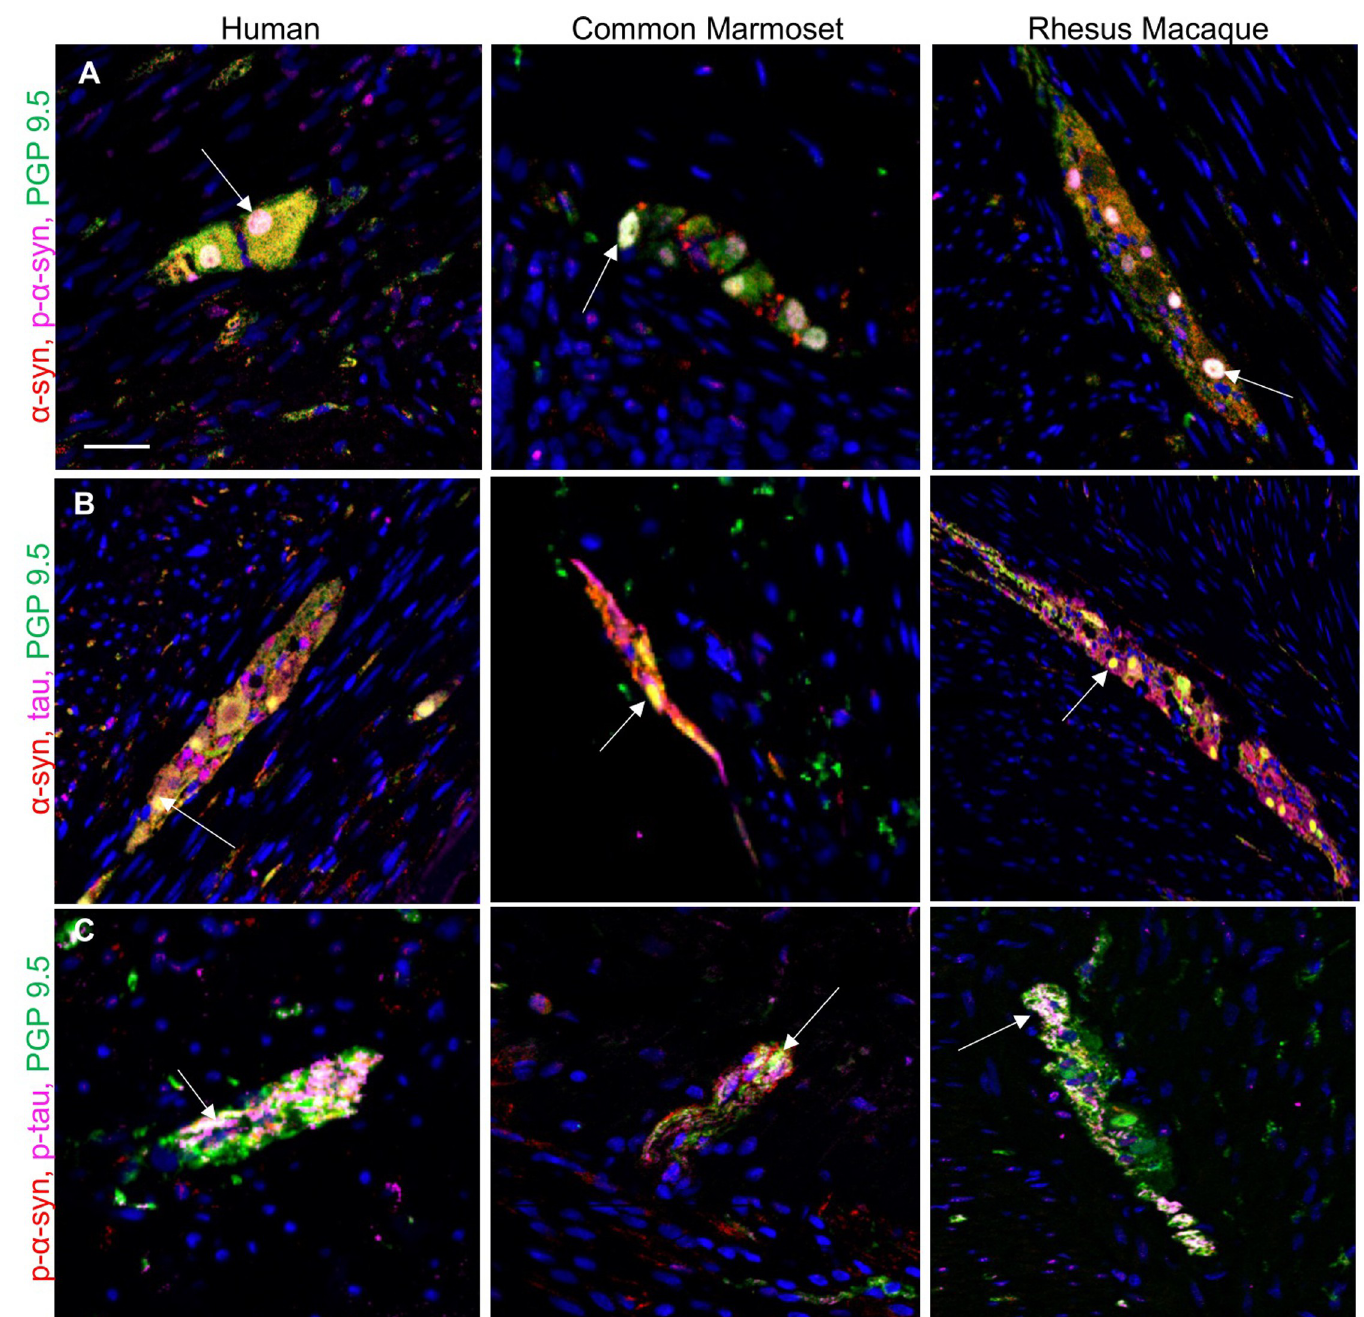
Fig 6. Representative photomicrographs showing immunofluorescent co-labeling. (A) α -syn, p- α -syn and PGP9.5 (B) α -syn, tau and PGP9.5 (C) p- α -syn, p-tau and PGP9.5, in myenteric ganglia in human appendix, common marmoset cecum and rhesus macaque cecum. Abbreviations: p- α -syn, serine 129 phosphorylated alpha- synuclein; p-tau, phosphorylated tau; PGP9.5, protein gene product 9.5. Scale bar: 50 μ m. https://doi.org/10.1371/journal.pone.0269190.g006 most of NHPs, including macaques and marmosets [1]. Our findings confirmed the presence of Peyer’s patches within the mucosa of human appendix and the cecum of marmosets and rhesus. The lymphoid follicles had similar area across species, but their number was greater in